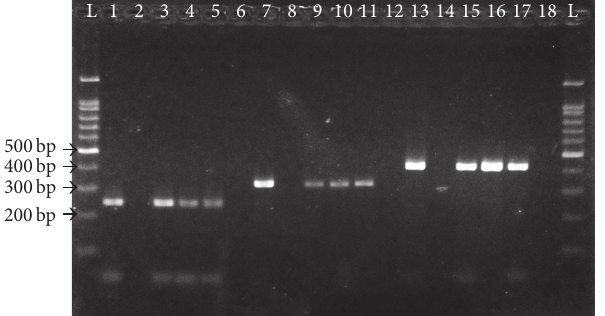
Figure 2: Representative gel image of PCR amplification. Lanes